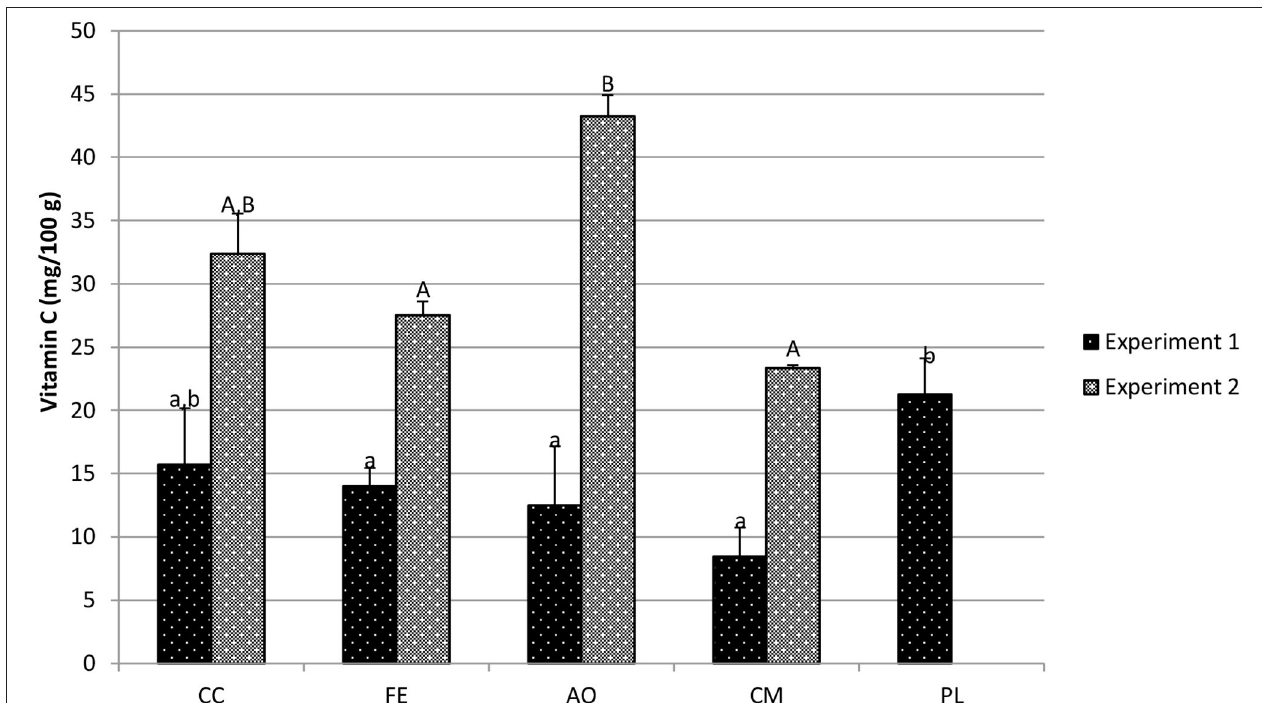
FIGURE 6 | Red giant mustard vitamin c concentration (mg/100g fresh weight) in harvested biomass—experiment 1 and experiment 2. Data shown are mean ± standard deviation for two different replicate experiments. Significant differences among mean values are indicated with different letters above bars ( p < 0.05) with lower-case letters for experiment 1 and capital letters for experiment 2. Results analyzed using ANOVA Tukey HSD for significance